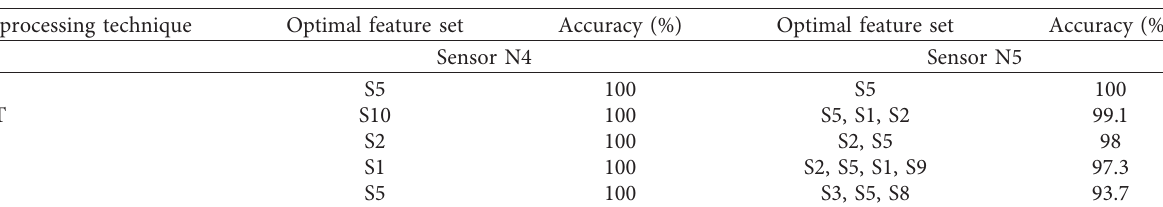
Table 3: Classification accuracy of the selected feature subset obtained by using different feature extraction methods for bridge health monitoring benchmark problem (case B).